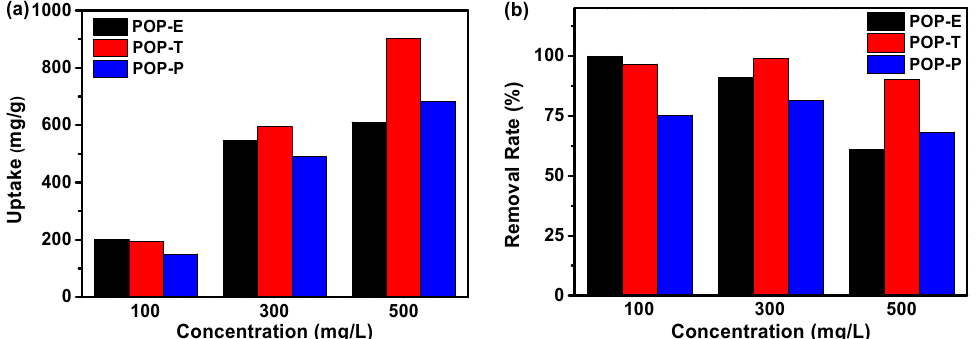
Figure 6. ( a ) Iodine uptake performance of POP-E, POP-T and POP-P in n-hexane solution. ( b ) Removal rate of POP-E, POP-T and POP-P for iodine in n-hexane solution.